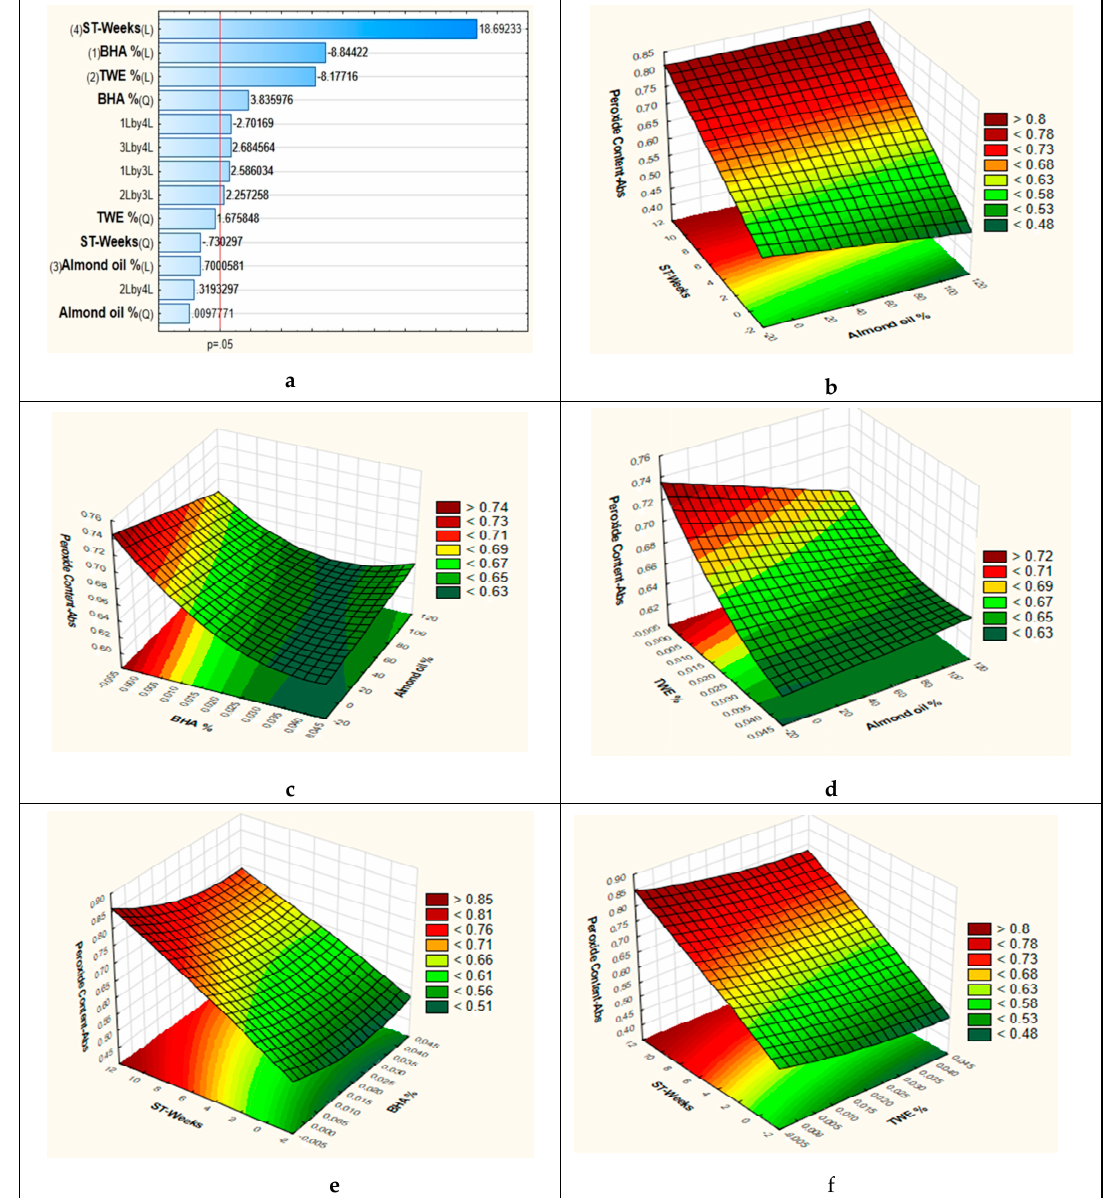
Figure 3: (a): Pareto chart showing the effects of the significant model coefficients. ( b): Response surface plot Figure 3. ( a ): Pareto chart showing the e ff ects of the significant model coe ffi cients. ( b ): Response surface showing the combined effect of storage time and emulsion almond oil %. ( c): Response surface plot showing plot showing the combined e ff ect of storage time and emulsion almond oil %. ( c ): Response surface the combined effect of BHA concentration and emulsion almond oil %. ( d): Response surface plot showing the plot showing the combined e ff ect of BHA concentration and emulsion almond oil %. ( d ): Response combined effect of thyme extract concentration and emulsion almond oil %. ( e): Response surface plot showing surface plot showing the combined e ff ect of thyme extract concentration and emulsion almond oil the combined effect of BHA concentration and storage time. ( f): Response surface plot showing the combined %. ( e ): Response surface plot showing the combined e ff ect of BHA concentration and storage time. effect of thyme extract concentration and storage time. . TWE: Thyme waste extract; ST: storage time. ( f ): Response surface plot showing the combined e ff ect of thyme extract concentration and storage time. The presence of thyme waste extract strongly influences peroxide formation in all types of TWE: Thyme waste extract; ST: storage emulsions in the same way as BHA. The peroxide levels decreased with the increase in thyme waste extract concentration (Figure 3d), this is due to the same antioxidant effect exerted by this extract.